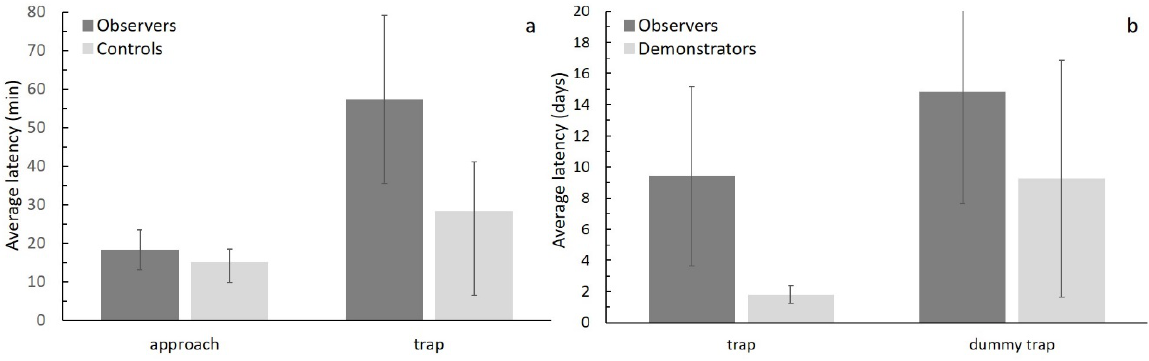
Note. (a) In Experiment 1, observer coyotes ( n = 14) were able to watch a demonstrator get captured before encountering a trap, and latency to approach and latency to get captured were compared to control coyotes ( n = 8), that had not observed a conspecific get trapped. Illustrated results do not include (1) one observer coyote that did not get caught, and (2) one control and one observer coyote where the camera trap system failed, and we could not obtain latency times for capture and approach. (b) In Experiment 2, a trap was placed in an enclosure with a male-female mated pair of coyotes, and the first coyote captured served as the demonstrator ( n = 10). We compared latency to initial capture for demonstrator and observer coyotes for the real set and a dummy set, where no trap was set but the site was dug out and the lure was placed. Illustrated results show average latency times for coyotes that were captured ( n = 5 observers, n = 10 demonstrators for first capture; n = 5 observers, n = 4 demonstrators for dummy captures). Four demonstrator coyotes were also recaptured in real traps (latency: 15.5 ± 6.4